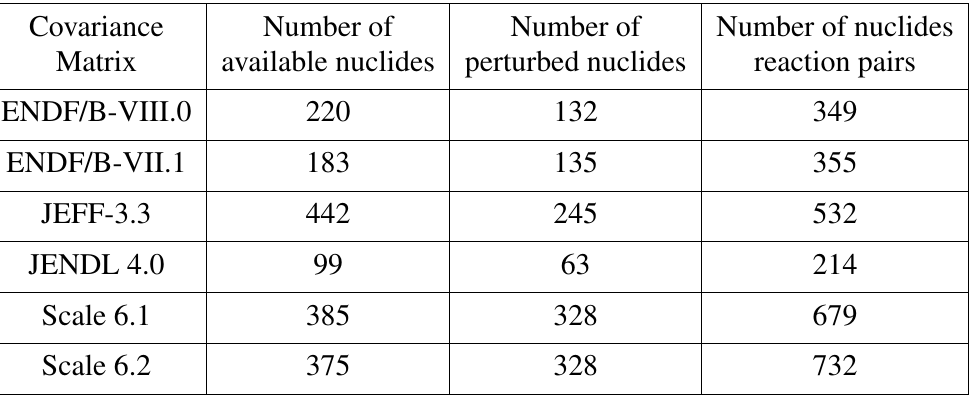
Table 1: Content of the covariance matrices. The number of available nuclides represents the number of ENDF files with a MF 33 record. The perturbed nuclides are the ones for which at least one reaction channel has been perturbed in the CASMO-5